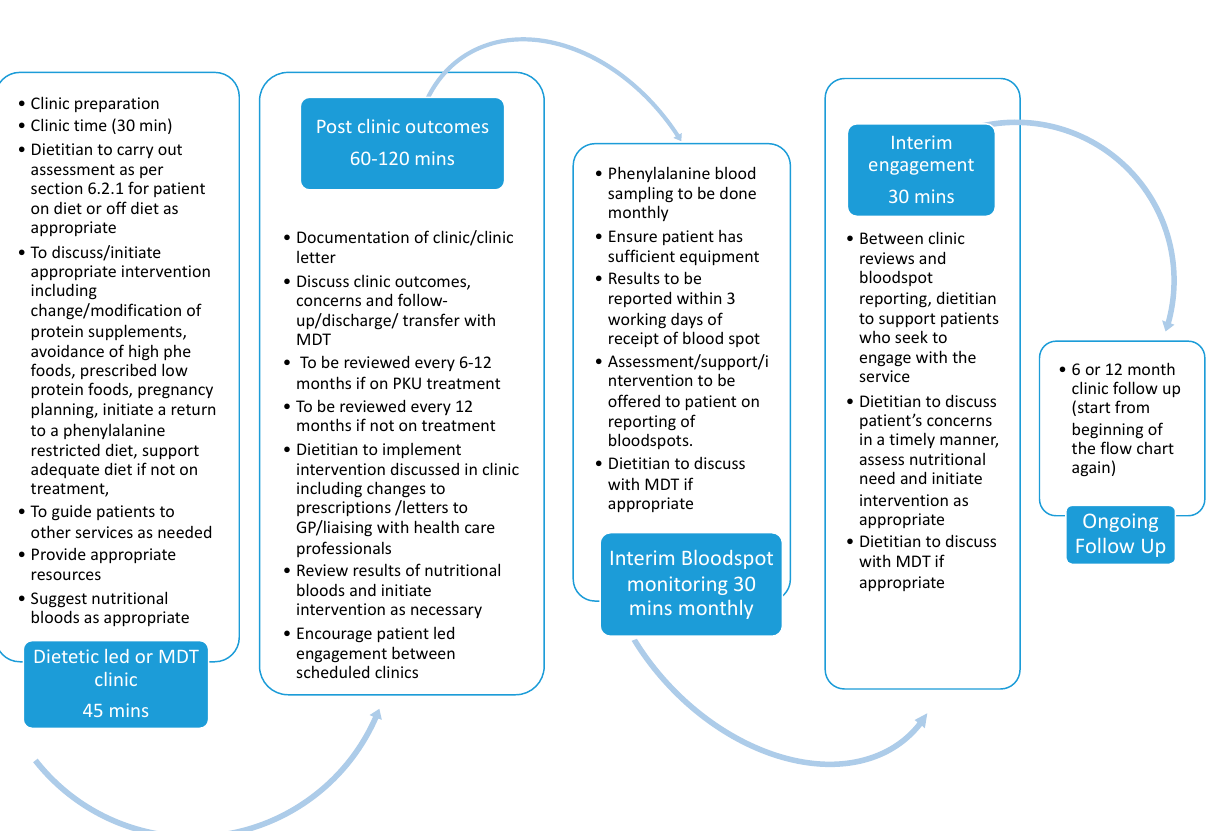
Figure A1. Pathway for Dietetic Management of Adults with Phenylketonuria (PKU) in the UK.